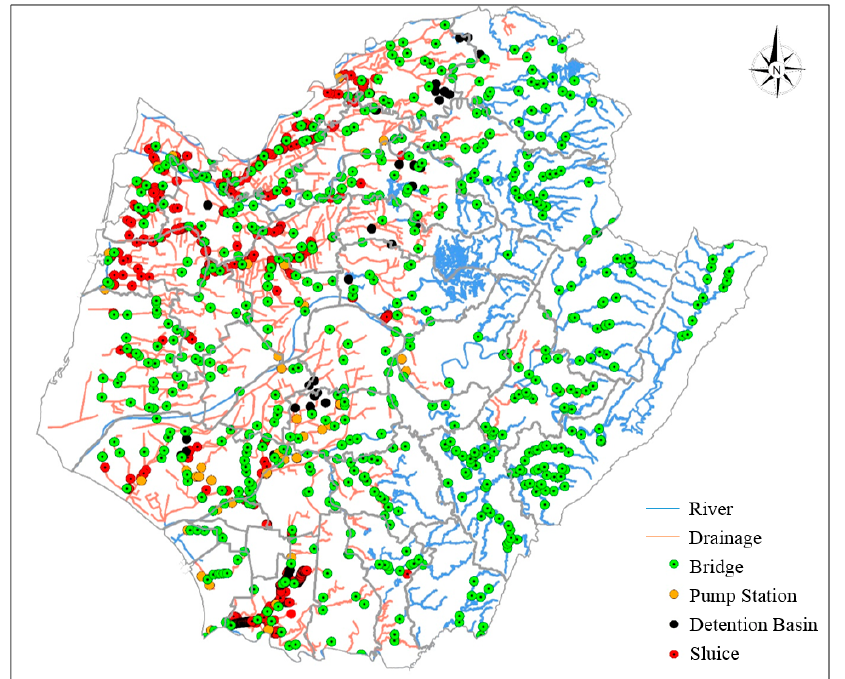
Figure 4. Network of river, drainage and hydraulic structures in Tainan City.